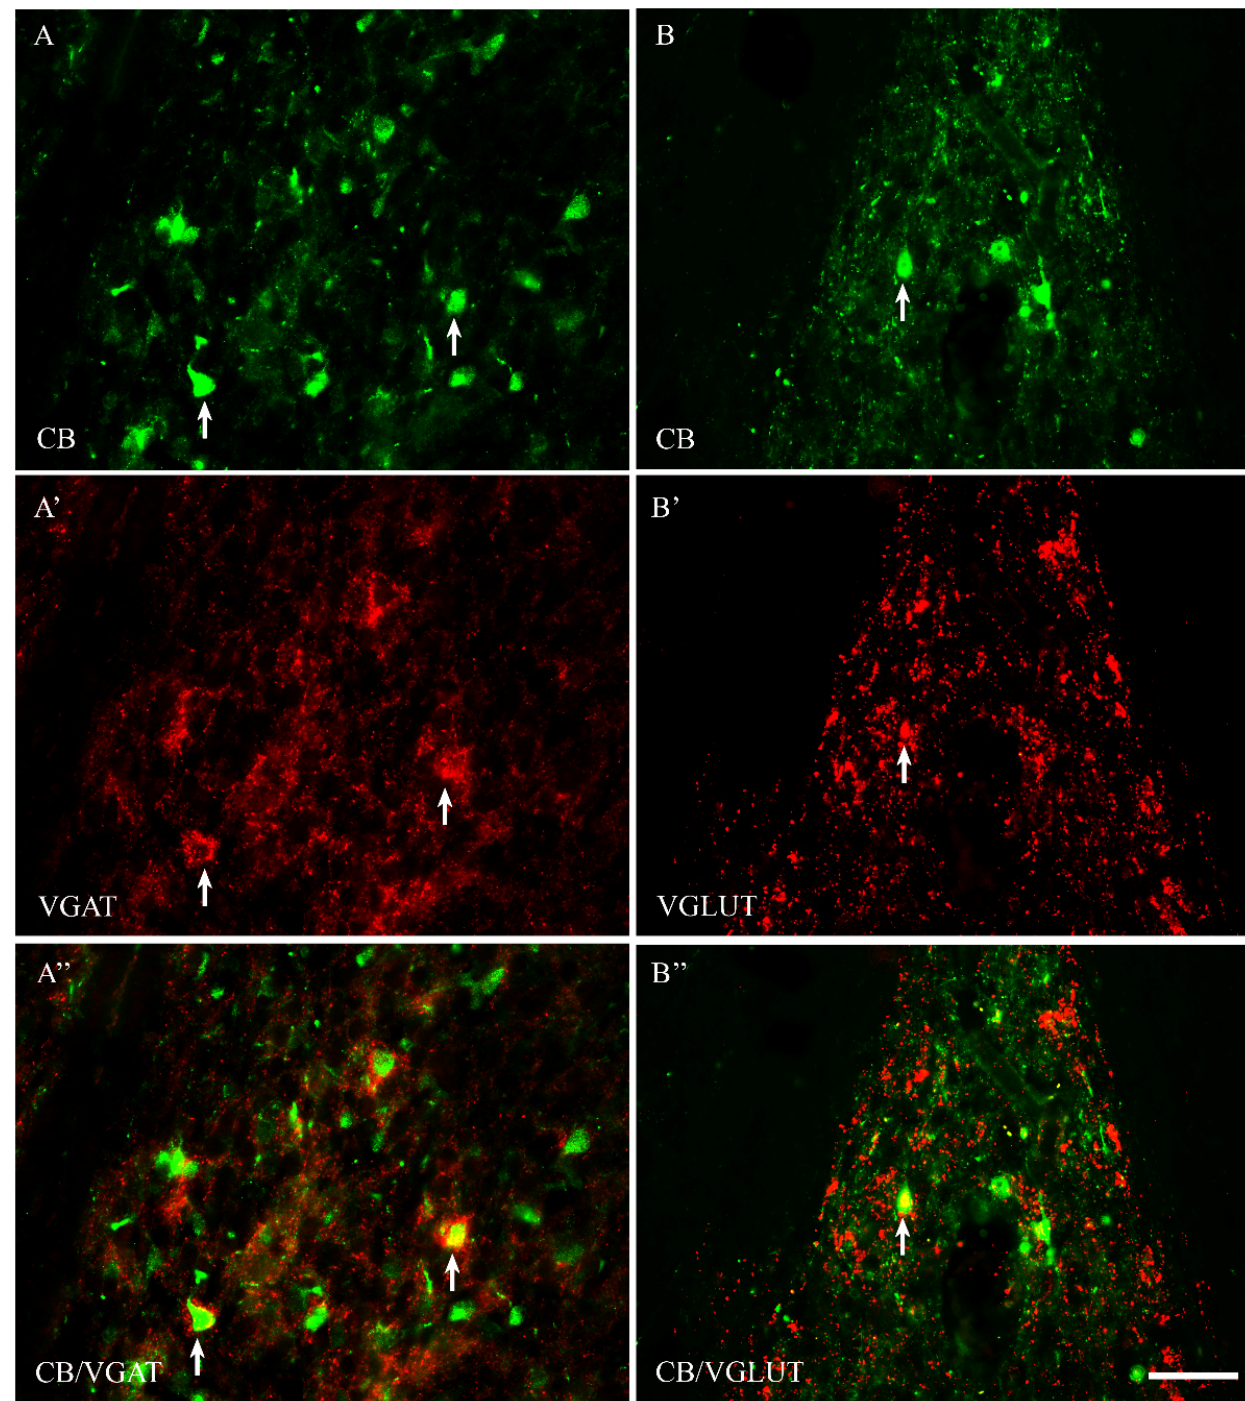
Figure 1. Representative microphotographs demonstrating the anatomical relationships between CB+ neurons and VGAT ( A – A” ) as well as CB+ neurons and VGLUT ( B – B” ) in the median preoptic nucleus of the guinea pig. Arrows indicate double-labelled cells. Scale bar = 50 μ m.